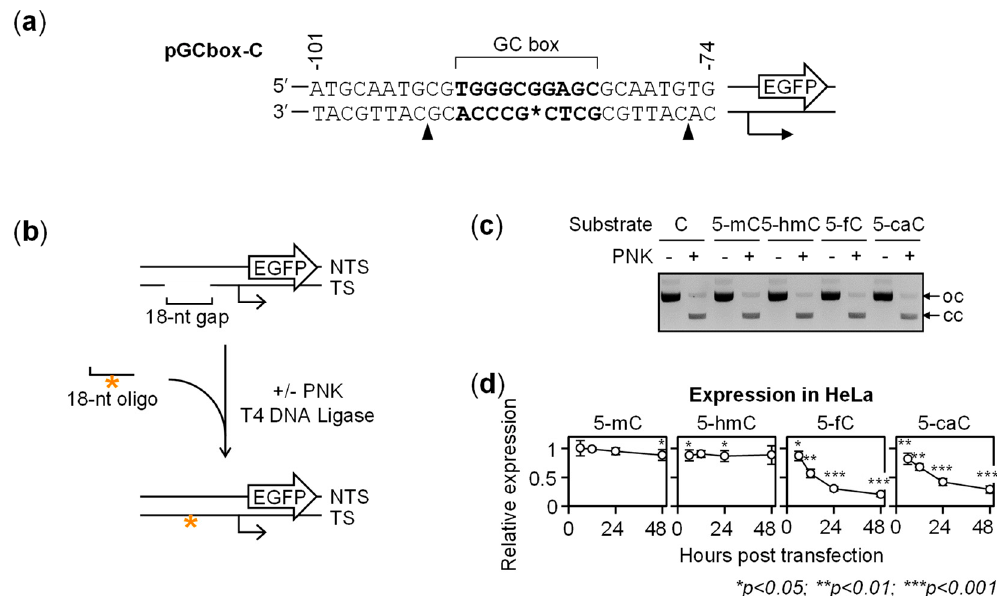
Figure 2. Effects of 5-mC, 5-hmC, 5-fC and 5-caC in the pyrimidine-rich strand of the GC box. ( a ) Promoter sequence with the modified cytosine position (asterisk) and Nb.BsrDI nicking sites (arrowheads). ( b ) Scheme of the incorporation procedure of C/5-mC/5-hmC/5-fC/5-caC (*) into the pyrimidine-rich strand of the GC box. ( c ) Agarose gel electrophoresis of the reporter constructs containing C/5-mC/5-hmC/5-fC/5-caC. The open circular (oc) and covalently closed (cc) forms are indicated by arrows. ( d ) The expression time course in transfected HeLa cells (mean ± SD) for n = 6 independent experiments (the 12-h point was skipped in three of them). Representative flow cytometry data are shown in Supplementary Materials Figure S1.